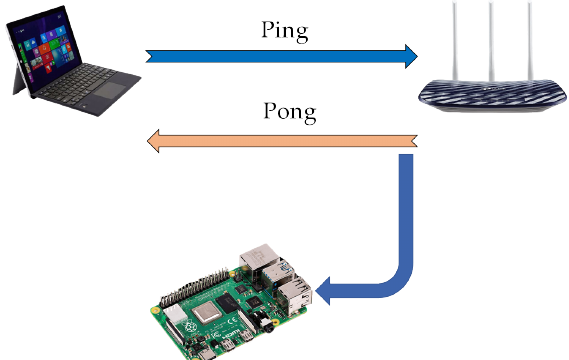
Figure 5. Configuration for CSI